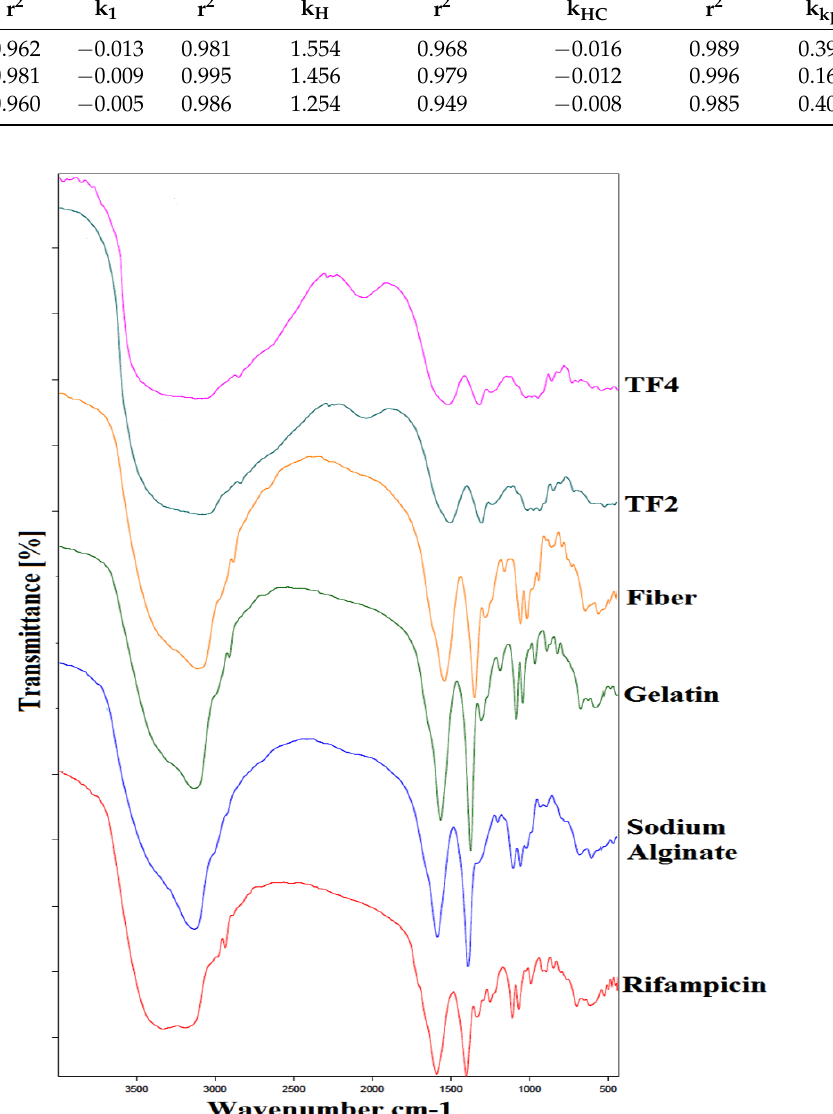
Figure 4. FTIR spectra of drug (rifampicin), sodium alginate, gelatin, fibers (rifampicin loaded), fiber-in-film TF2 batch, and fiber-in-film TF4 batch.